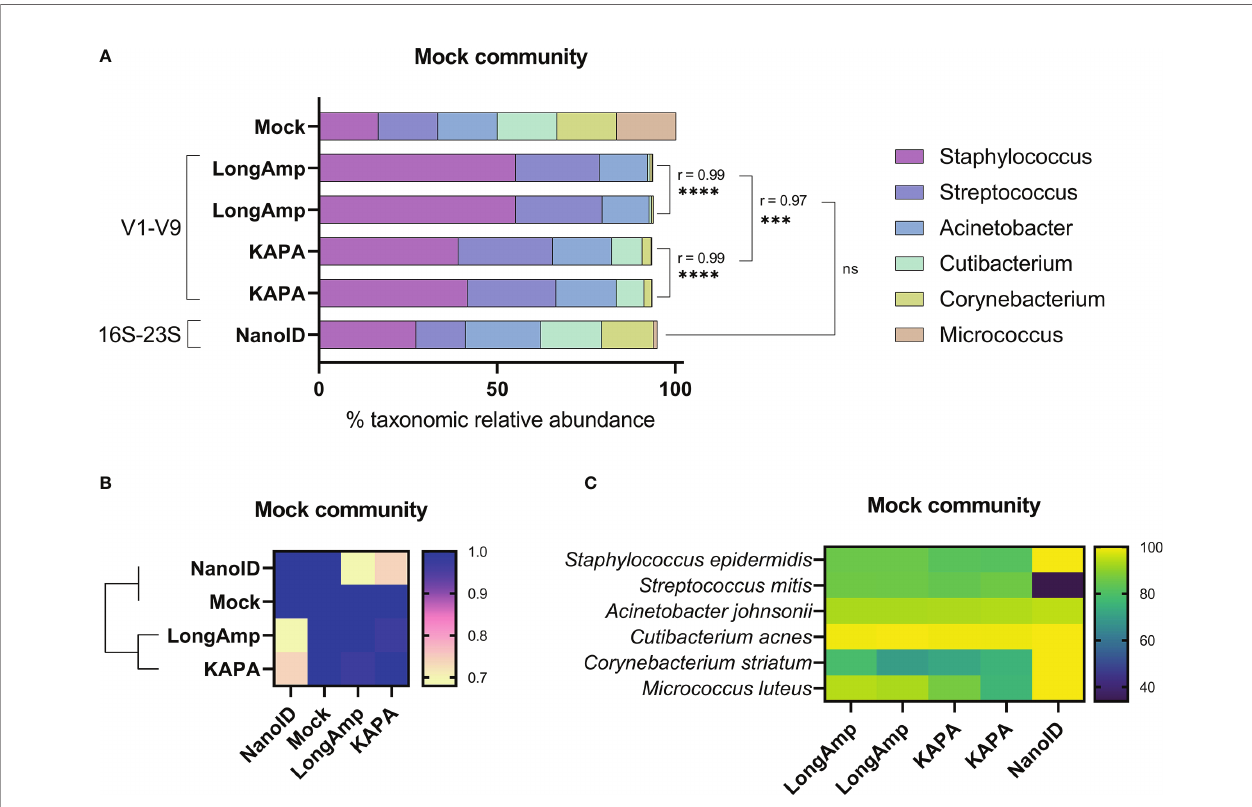
FIGURE 1 | Testing ofdifferent ampli fi cation methodologies for MinION ™ sequencing of human mockskinmicrobial communities. (A) Comparisonof taxonomic pro fi les of classi fi edreads of the mock community.The Pearsoncoef fi cient (r) between sequencing methodswas computed to highlight a signi fi cantcorrelation between samples and/ or methodologies. ns, not signi fi cant; ***P ≤ 0.001; ****P ≤ 0.0001. (B) Similarity matrix and hierarchicalclustering ofthe methodologies based ontheir relative abundance pro fi les. (C) Heat mapshowing the percentage of classi fi edreads to the correct species between the sequencing methodsin the mock